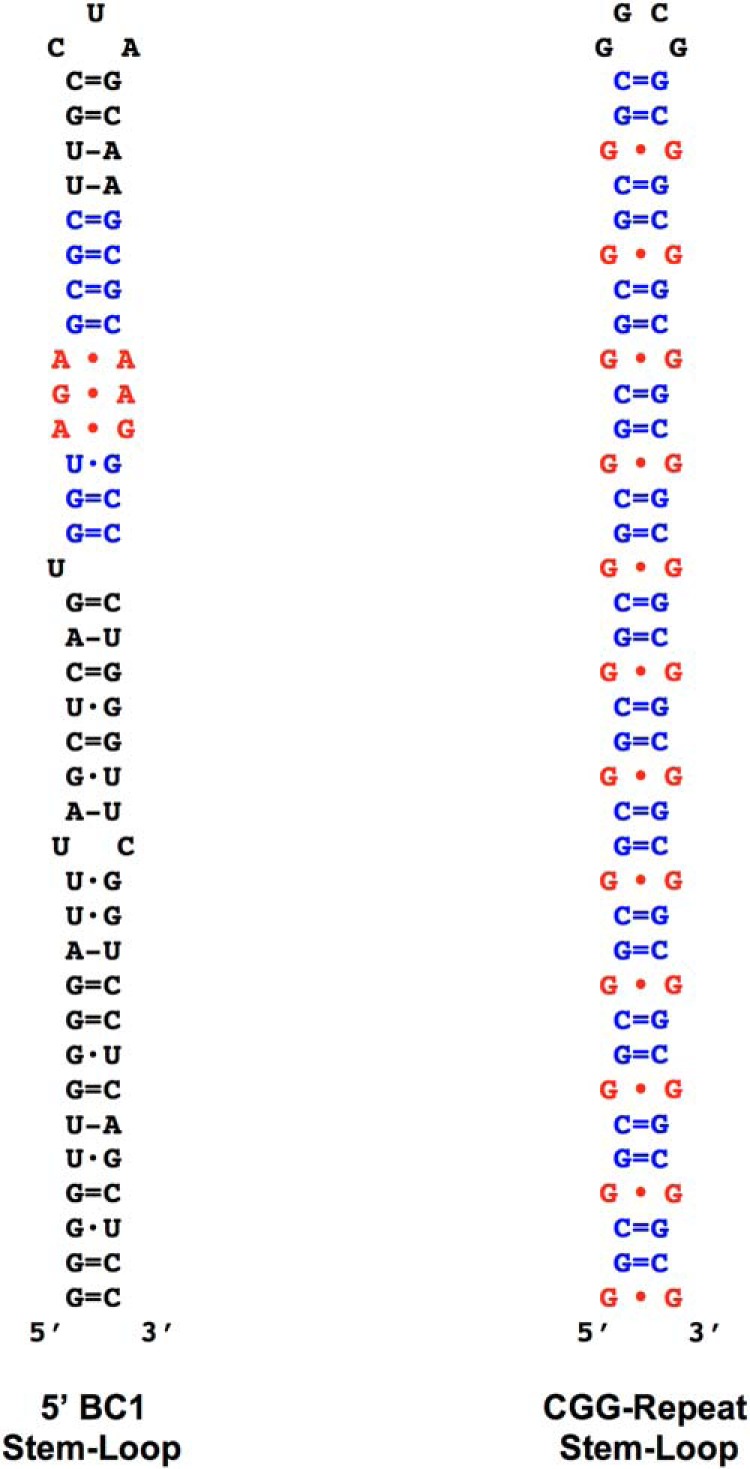
BC1 RNA DTE and CGG-repeat stem-loops: noncanonical motif structures. Noncanonical purine∙purine pairs are symbolized by ∙, standard WC pairs by = (GC) or – (AU), wobble WC pairs by ·. In the BC1 RNA DTE, the noncanonical GA core motif resides in an A-form helix that is part of the 5′ BC1 apical stem-loop domain (Muslimov et al., 2006; 2011). The GA core (red) is clamped by canonical base pairs which are mostly G=C standard WC (blue). The structure of the 5′ BC1 domain was established experimentally (Rozhdestvensky et al., 2001). In CGG-repeat stem-loops, noncanonical G∙G pairs (red) are flanked by G=C standard WC pairs (blue; Napierala et al., 2005; Zumwalt et al., 2007; Kiliszek et al., 2011). Noncanonical R∙R pairs (e.g. A∙G, G∙G) are rather strong, comparable in stability to A-U WC pairs (Mládek et al., 2009; Sobczak et al., 2010).